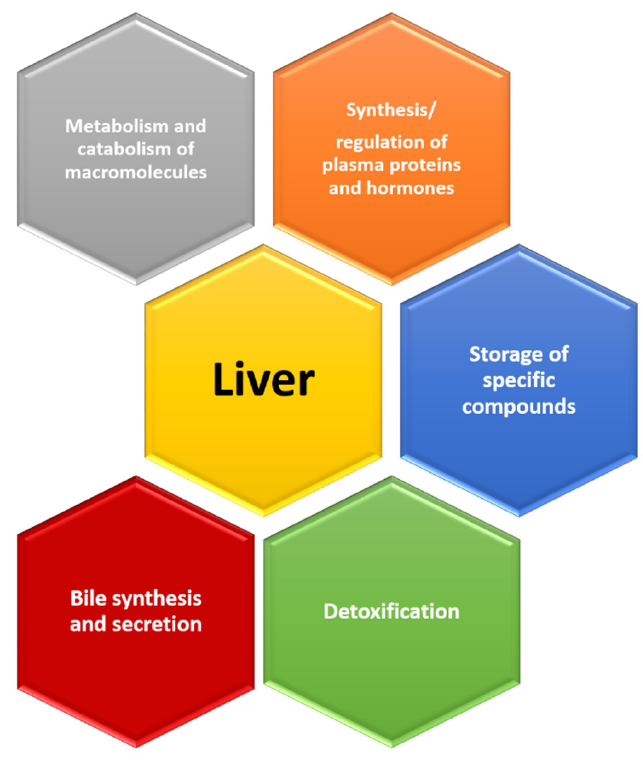
Figure 4. Roles of the liver.